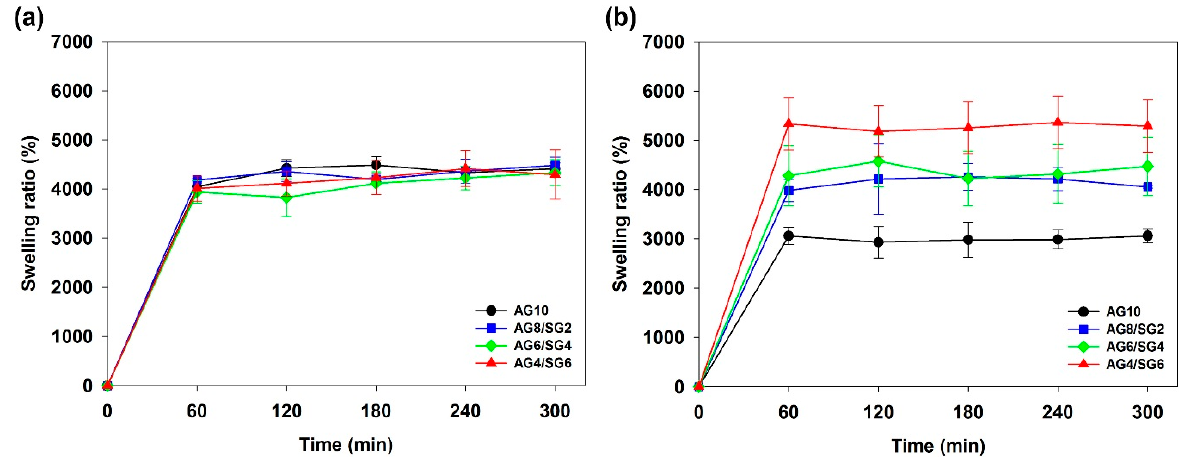
Figure 7. Swelling ratio curves for agarose/succinoglycan hydrogels in buffer ( a ) pH = 1.2 and ( b ) pH = 7.4 solution at 37 °C.